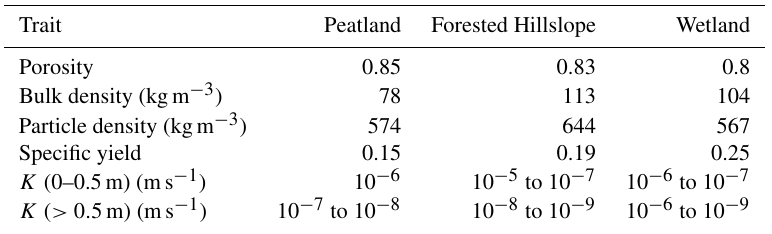
Table 2. Soil characteristics in each typical soil-covered landscape type present in the Baker Creek Research Watershed. K denotes hydraulic conductivity.